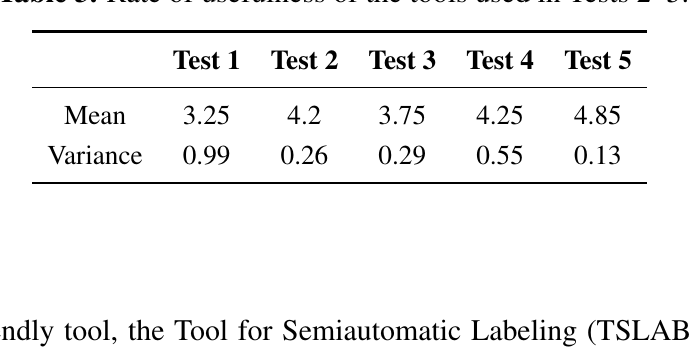
Table 3. Rate of usefulness of the tools used in Tests